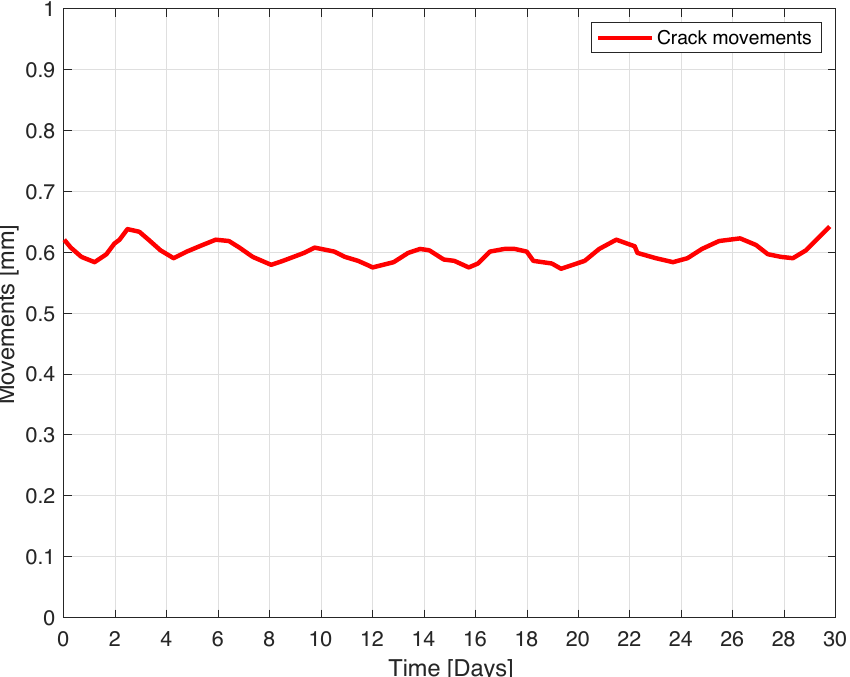
Figure 17. Crack movements vs. time. The tag placed on position C in the north side of the building, showing a safe